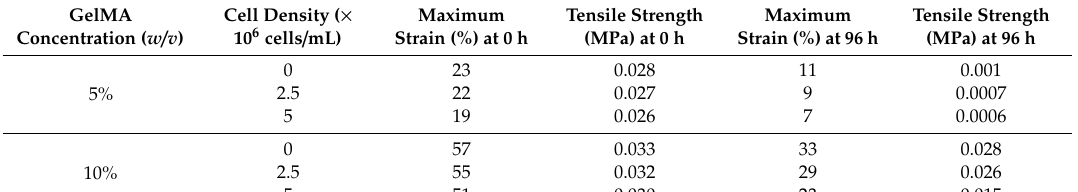
Table 1. Summarized results of mechanical testing of cell-encapsulated GelMA samples.